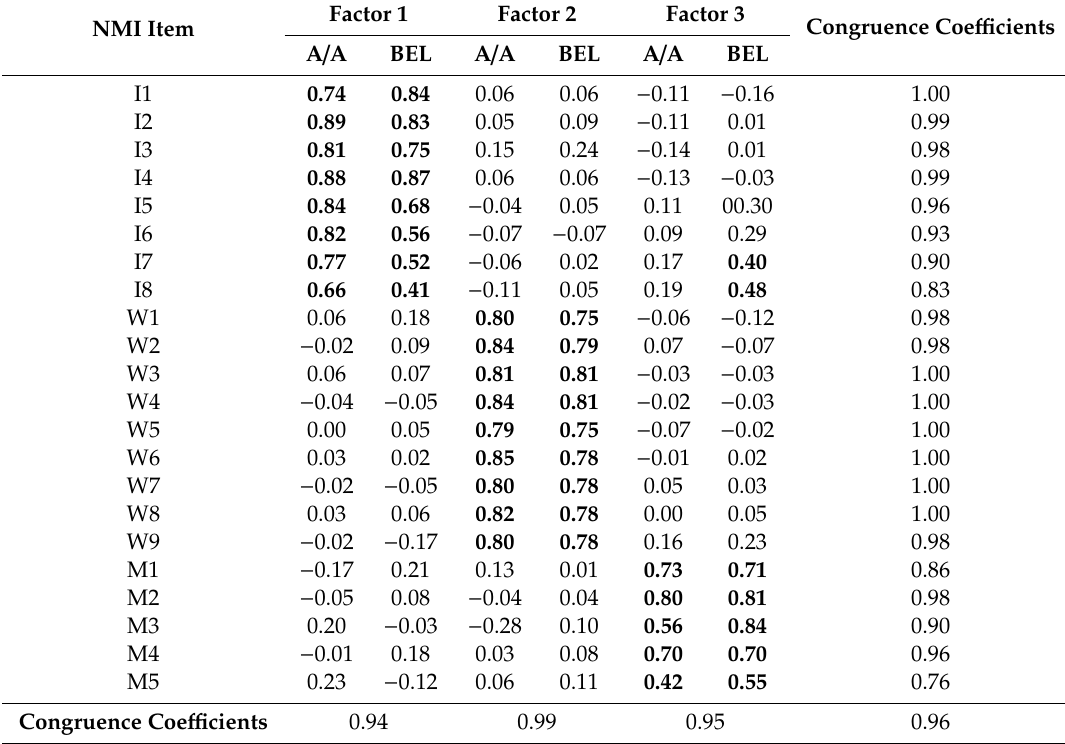
Table 2. Comparison of the pattern loadings for the Numinous Motivation Inventory (NMI) Items between atheists / agnostics and other faith